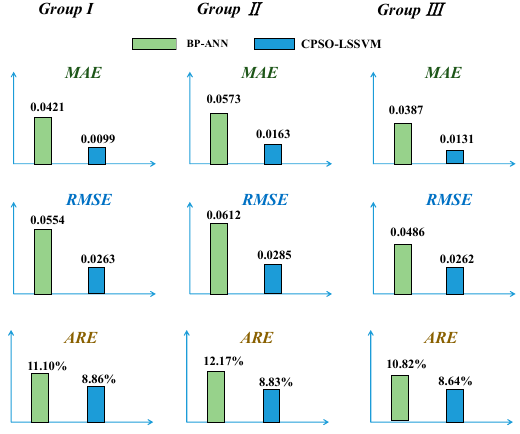
Figure 11. The statistical results of the three groups.